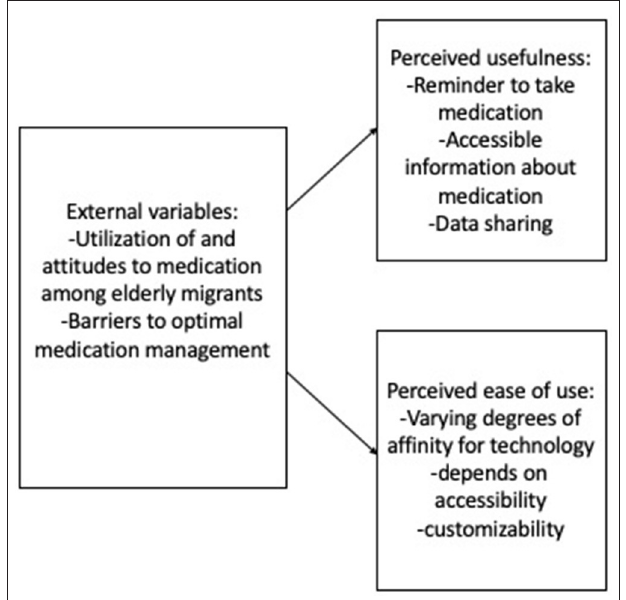
FIGURE 4 | Factors playing a role in technology acceptance (24, 25) for a mobile medication management application for older adults of Turkish descent with chronic